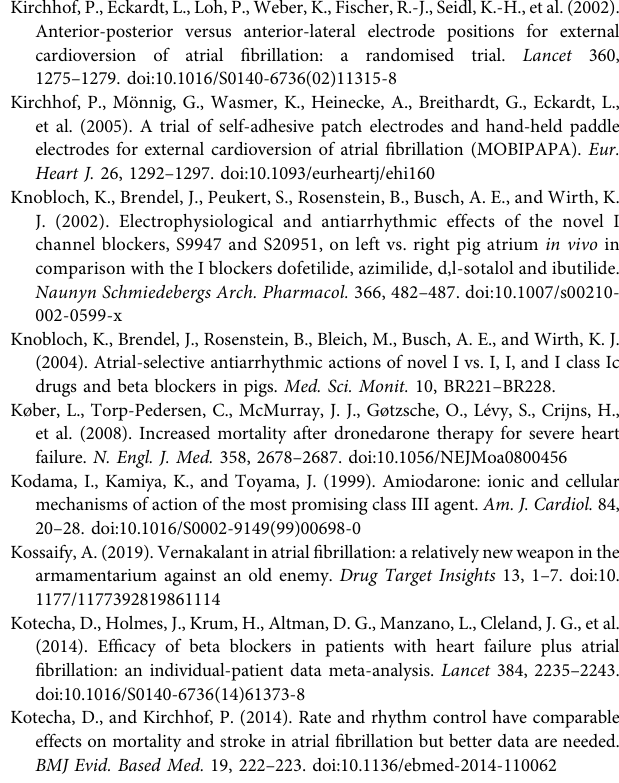
REferral centre. Eur. Respir. J. 39, 945 – 955. doi:10.1183/09031936.00078411 Jafari-Fesharaki, M., and Scheinman, M. M. (1998). Adverse effects of